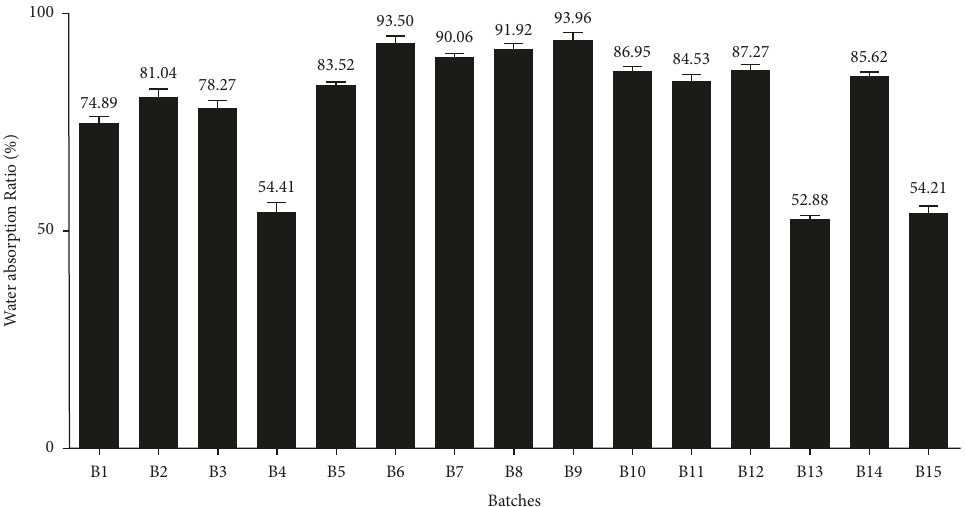
Figure 5: Bar diagram for the measurement of water absorption ratio (in percentage) for different batches.